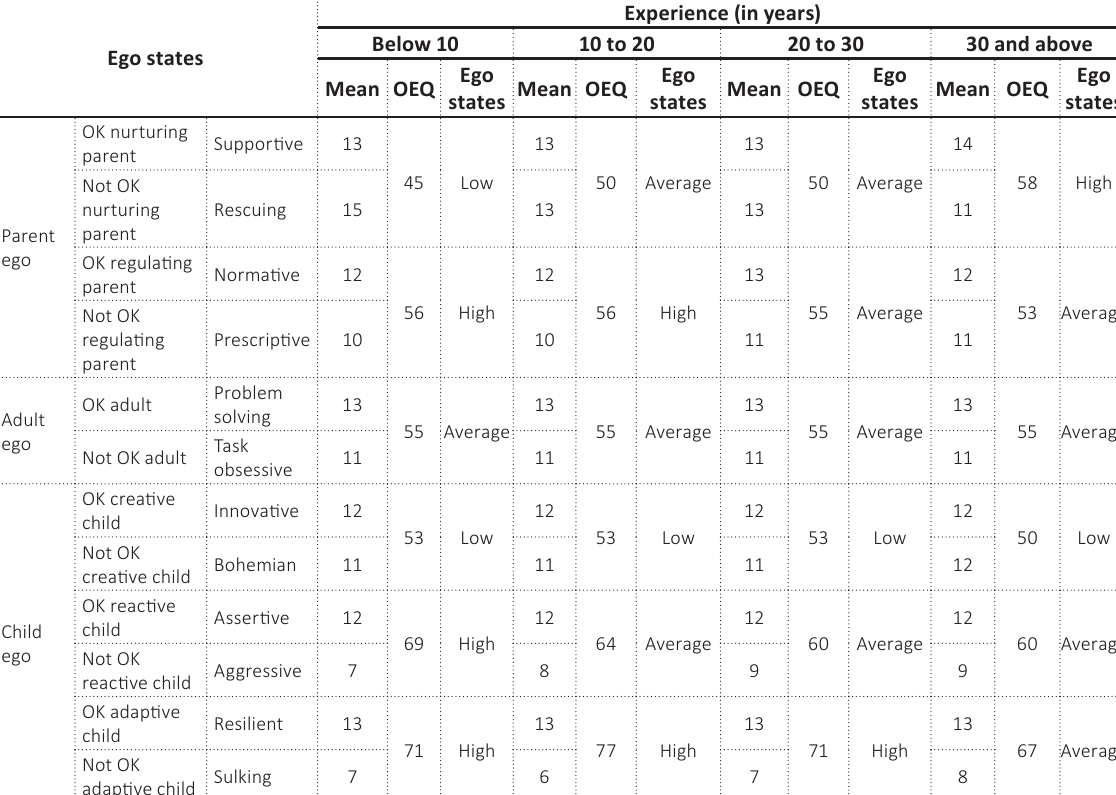
Table 5. Level of ego states based on experience